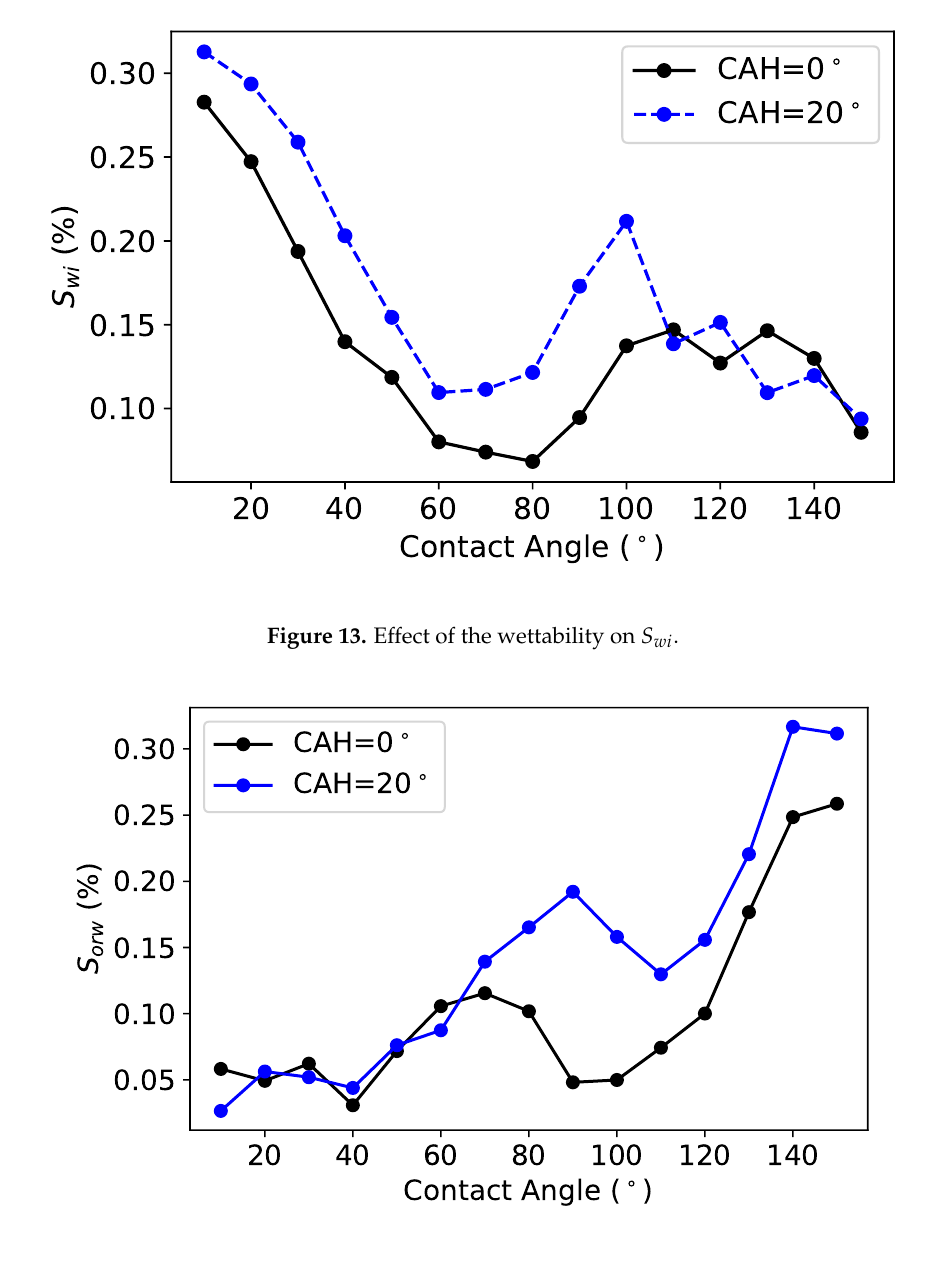
Figure 14. Effect of the wettability on S or